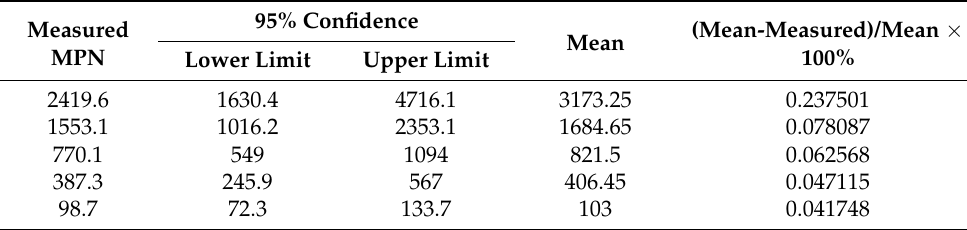
Table 2. Uncertainty test.